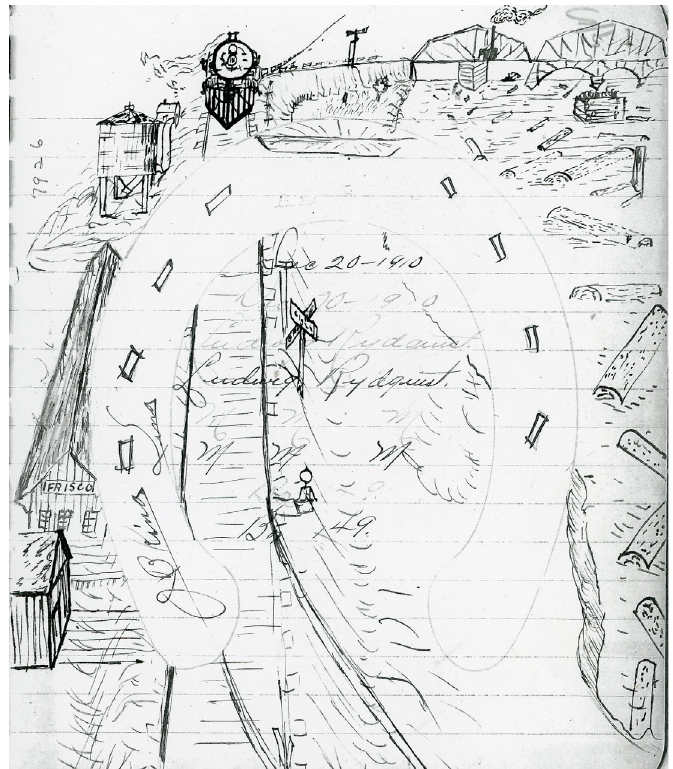
Figure 2: The hand-drawn cover of Ludwig Rydquist’s 1910 notebook, depicting railroad activity flanking the log-filled Saint Croix River that forms the Minnesota-Wisconsin border (Photo: James P. Leary).